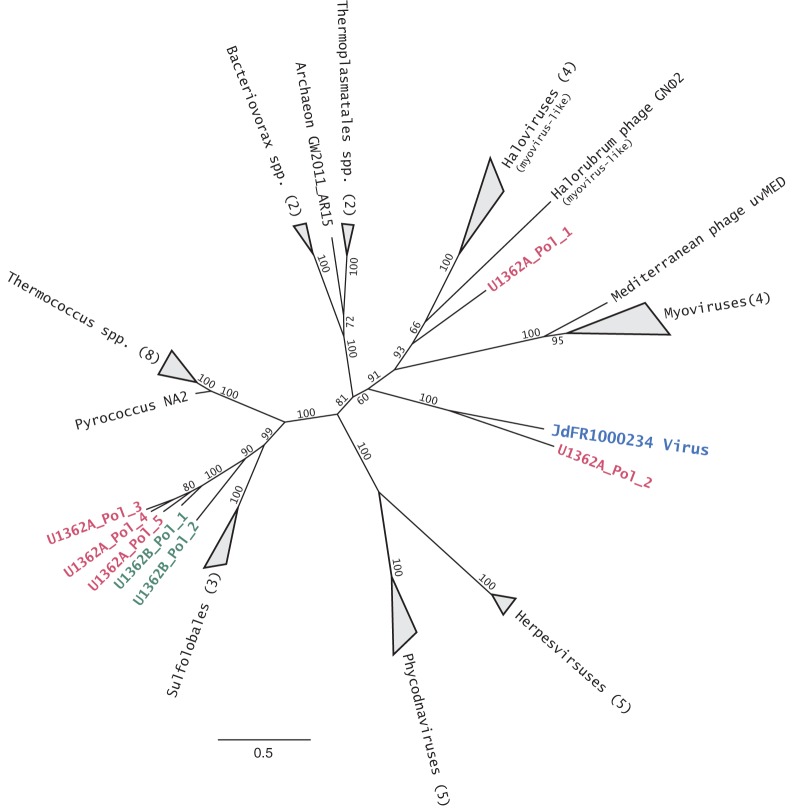
Maximum-likelihood phylogeny of the DNA polymerase II gene (polB) from viral genome JdFR1000234 (in blue boldface font) and homologous viral and archaeal amino acid sequences. Values at the nodes indicate percent bootstrap support, and the bar indicates 0.05 substitutions per site. Bootstrap values at some internal nodes were omitted for clarity. Colored font indicates sequences that were obtained from the U1362A (red) or the U1362B (green) metagenomes. A cluster of the sequences derived from these metagenomes branch within archaeal polB genes and are likely derived from archaea. The DNA polymerase B gene from JdFR1000234 forms a monophyletic lineage with another sequence from borehole U1362A that is different from all other known polB sequences. Identification numbers for the sequences are listed in Table S3.